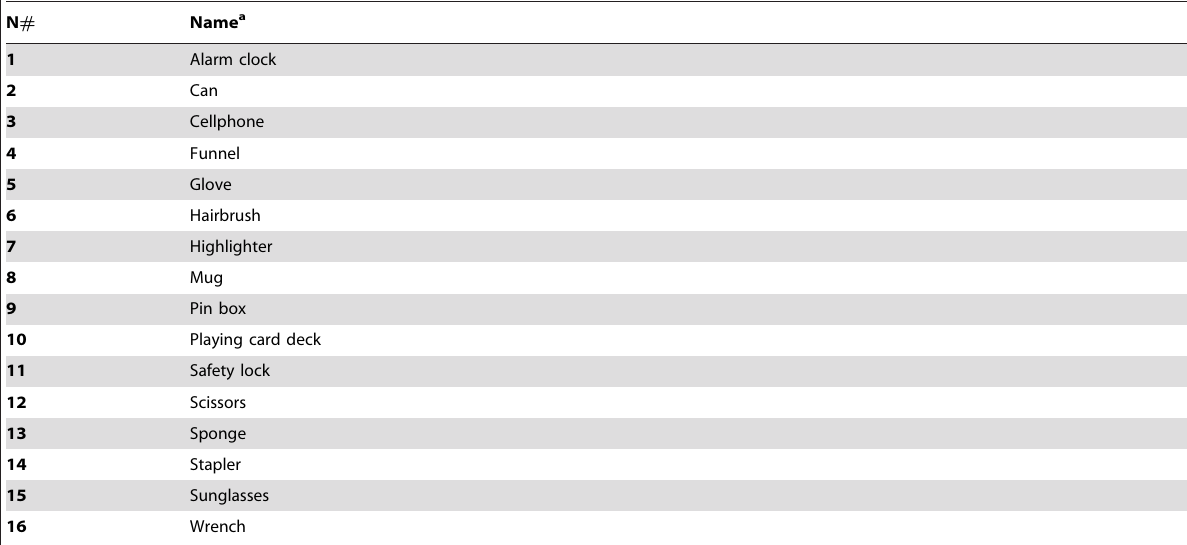
Table 1. Stimuli used in the study.